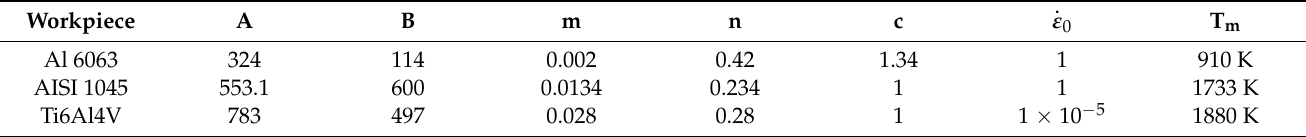
Table 4. Johnson-Cook parameters of workpieces [39,60,63].